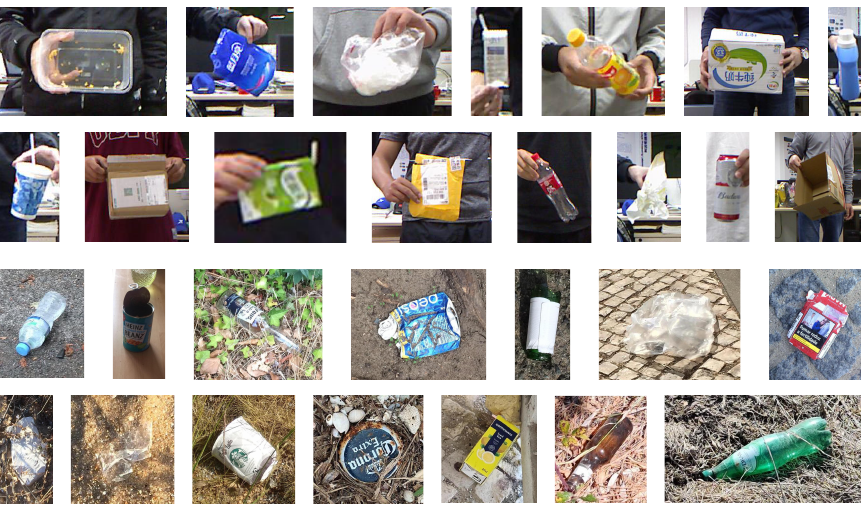
Figure 4. Example object region proposals. The first two rows show the object region proposals from the MJU-Waste dataset. The remaining two rows show the object region proposals from the TACO